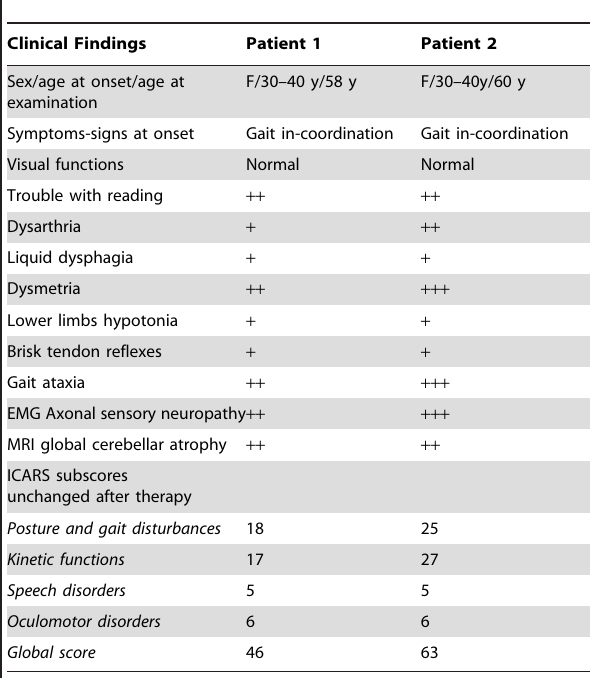
Table 1. Main clinical features of both patients, including ICARS